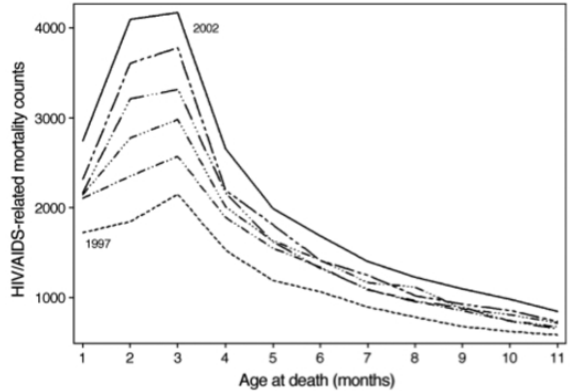
Fig. 2. Early peak in infant mortality proportional to rising antenatal HIV seroprevalence, 1997 - 2002 (reproduced with permission from AIDS 16